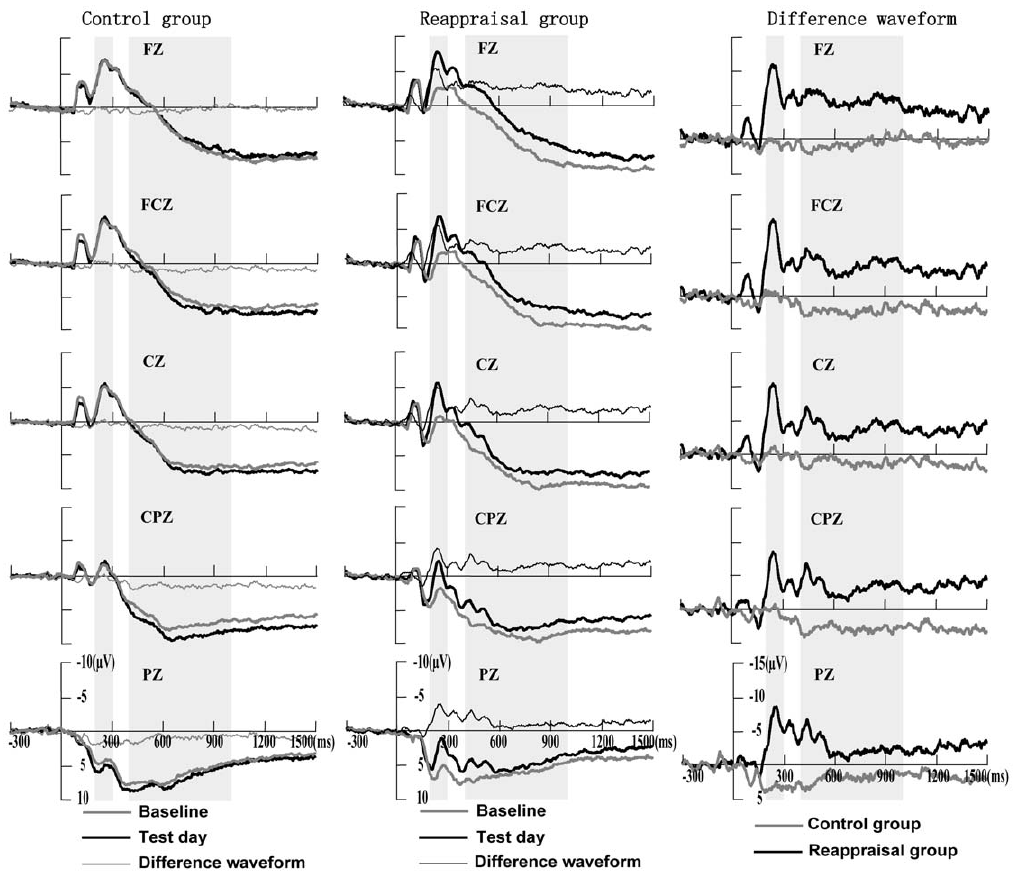
Figure 4. Changes of LPP for the control and the reappraisal groups. Left column: Grand averages for the control group; Middle column: Grand averages for the reappraisal group. Right column: Difference waveforms between the baseline and test days for the control and reappraise groups.